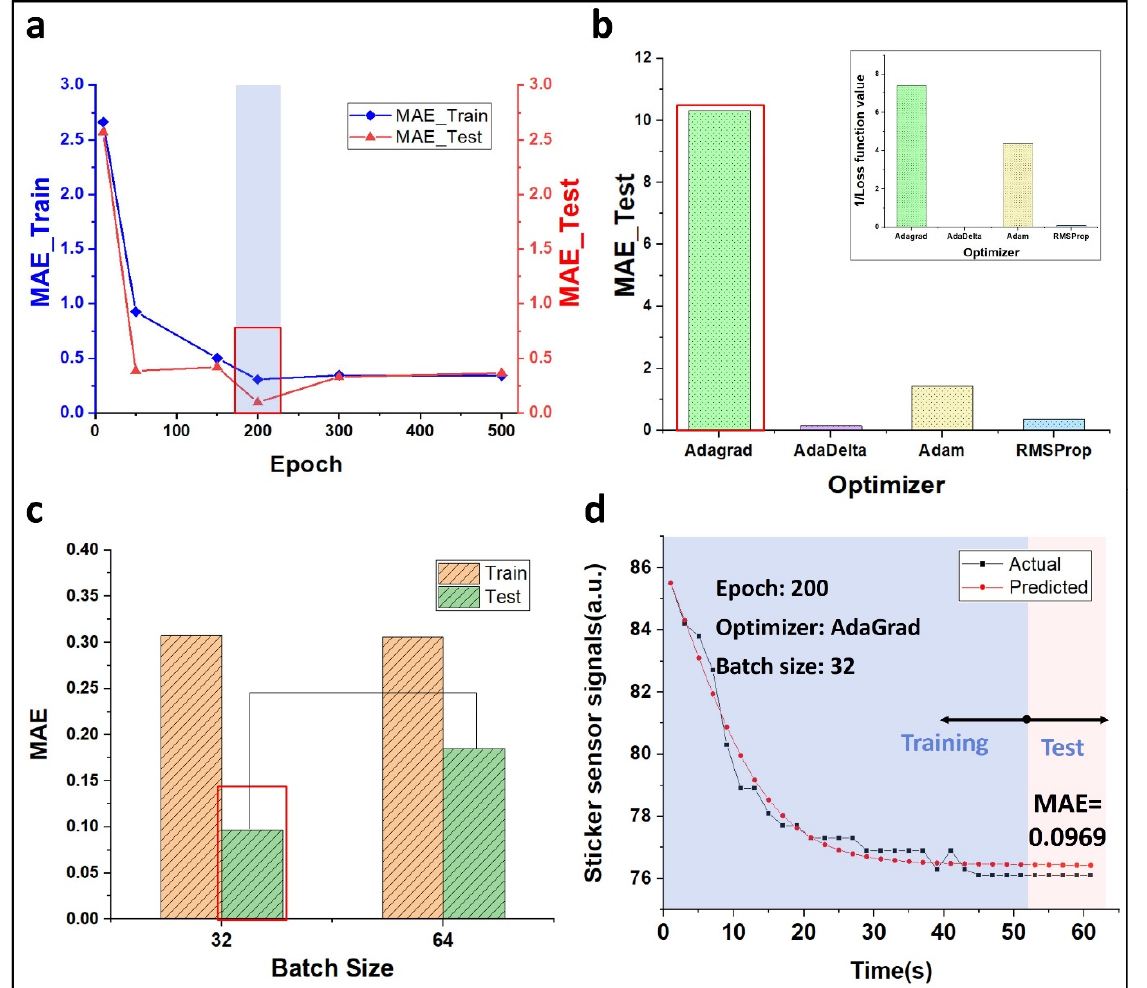
Figure 4. Time series analysis after the patch attachment using deep learning. ( a ) MAE graph according to epoch. The epoch defines the learning algorithm number that passes through the training set, and MAE has the more minor, the better characteristics. ( b ) Reciprocal of MAE according to the optimizer. The optimizer means updating the optimal weight to minimize the loss function to accelerate the learning speed. The AdaGrad function has the lowest training and tests MAE among optimizers. Additionally, the value of the loss function in the upper right has a similar tendency. ( c ) MAE trend according to batch size. Batch size 32 has a lower value compared to 64. ( d ) Actual data and prediction graph of sticker signal over time. In the test area, MAE, 0.0969 was finally